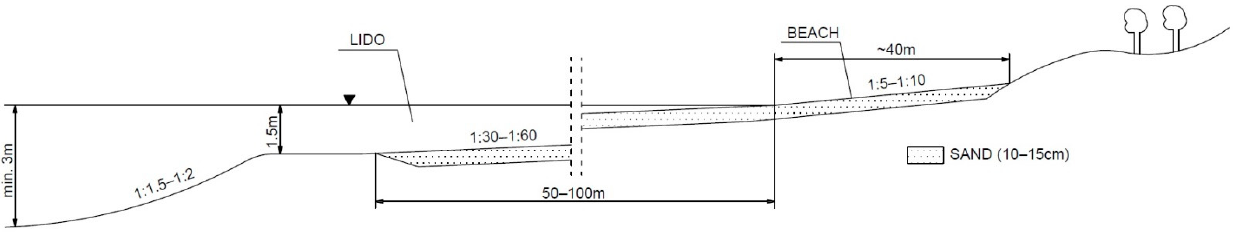
Figure 2. Profile of a lido in an old excavation pit of rock raw materials (own material based on Uberman and Uberman